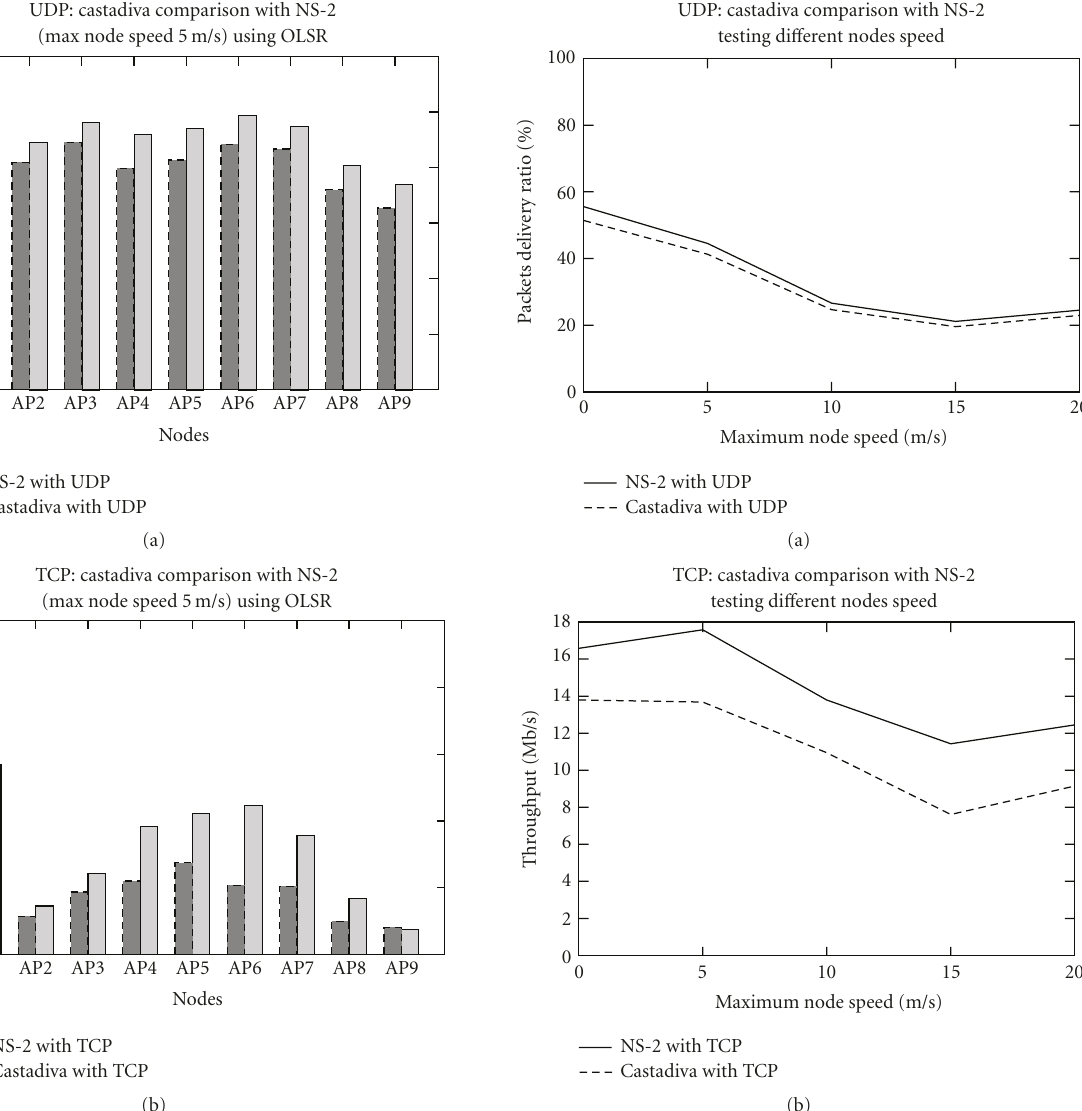
Figure 18: Comparison of Castadiva and ns-2 at di ff erent node speeds with both UDP (a) and TCP (b) tra ffi c. (routing